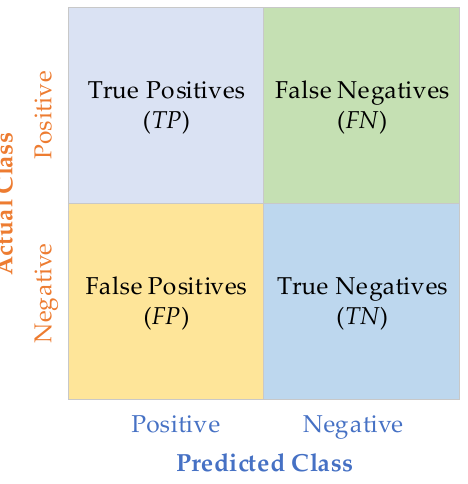
Figure 9. The definition of the confusion matrix. Table 3. The definition of evaluation